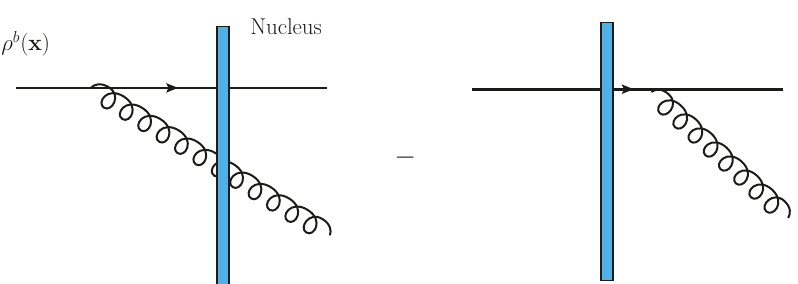
Figure 1 . Schematic diagrams showing the leading order single gluon production in high energy proton-nucleus collisions. The ρ b ( x ) is the valence color charge density of the proton. The colored solid rectangular represents the highly Lorentz contracted nucleus.